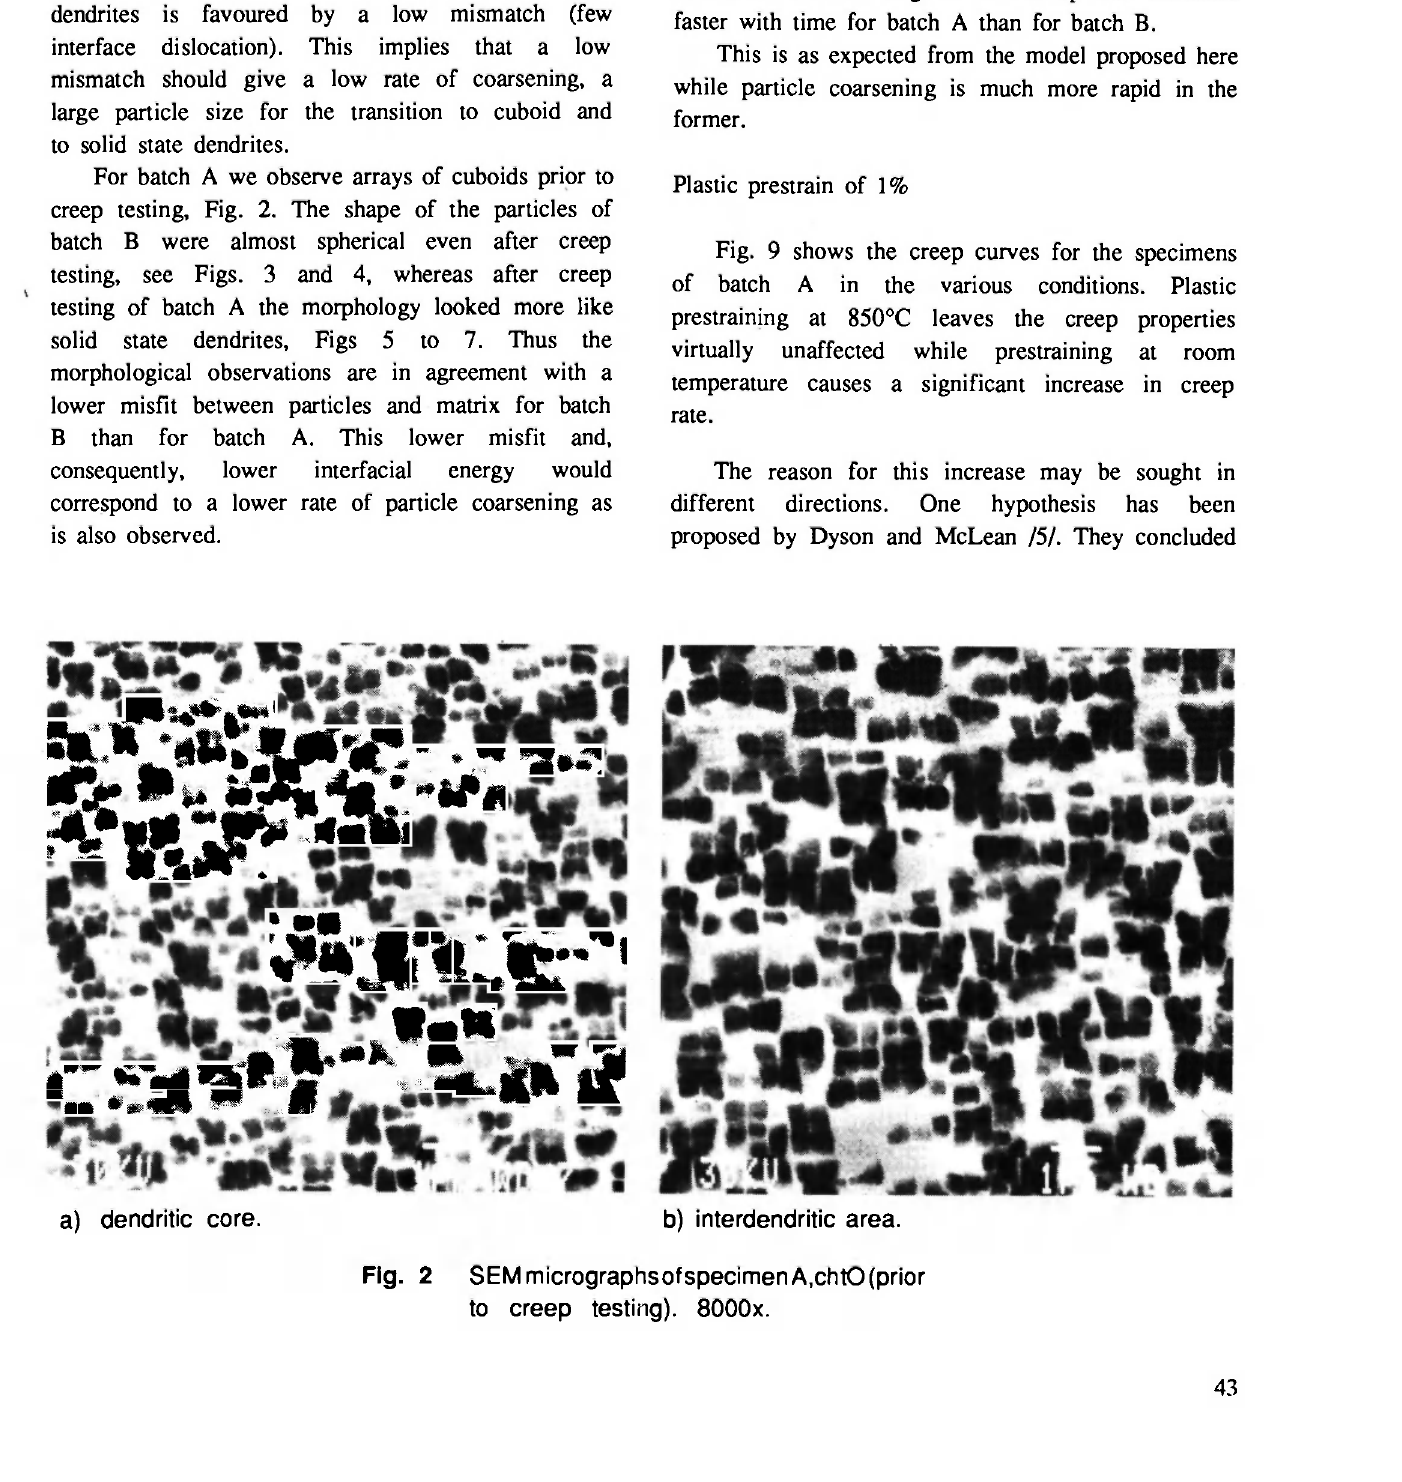
Fig. 2 SEM micrographs of specimen A,chtO (prior to creep testing).